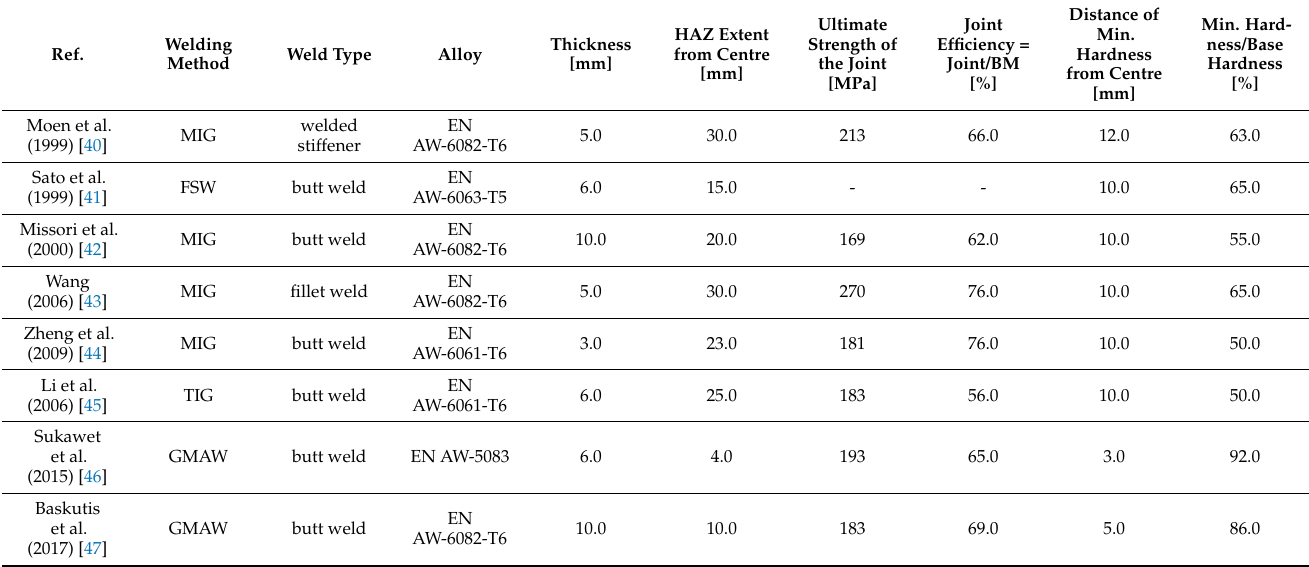
Table 1. Overview of the studies on the HAZ extent and ultimate strength.